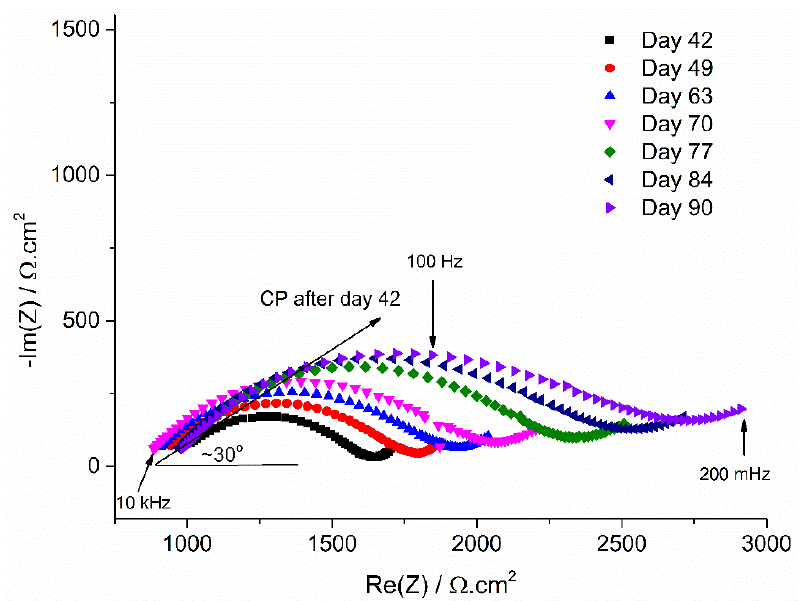
Figure 5. Evolution of the EIS Nyquist plots with exposure time for coupon WE CP1 ( E CP = − 1.0 V vs. Cu/CuSO 4 ) between days 42 and 90.